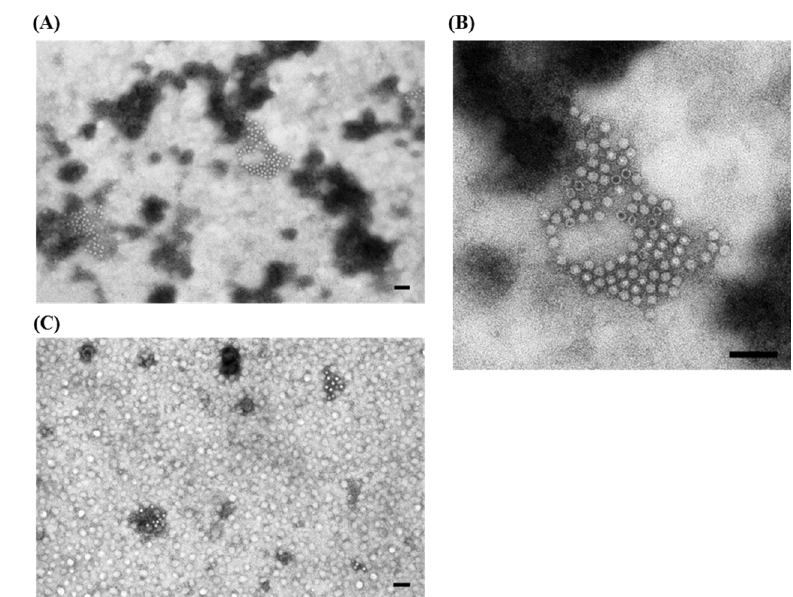
Figure 6. Electron micrograph of ultracentrifuged liver homogenate from a 20-day-old pheasant. ( A ) Aggregates of non-enveloped viral particles, 18–22 nm in diameter, morphologically corresponding to parvovirus, surrounded by fuzzy halos of antibodies are visible. Immuno-aggregation electron microscopy (IAEM) preparation with a pool of convalescent sera diluted 1:20; ( B ) Higher magnification of ( A ) showing the group of empty and full parvovirus-like particles; ( C ) IAEM negative control: single dispersed small viral particles are visible. Negative staining (2% sodium phosphotungstate). TEM Philips CM10, 80 kV. Bar = 100